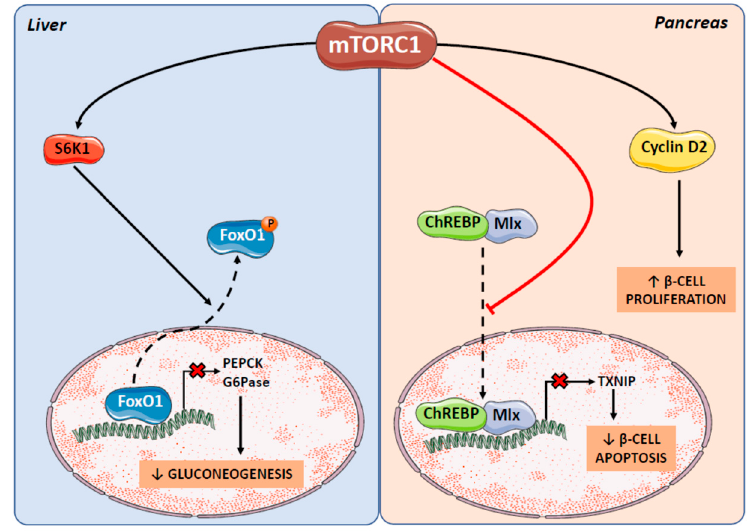
Figure 4. Effects of mTORC1 on carbohydrate metabolism. mTORC1 activation inhibits gluconeogenesis by promoting the phosphorylation and nuclear exclusion of FoxO1 via S6K1, which blocks its transcriptional effect on the main gluconeogenic genes PEPCK and G6Pase. Carbohydrate metabolism may be also indirectly altered by mTORC1 effects on the survival and proliferation of insulin-secreting pancreatic β‐ cells.